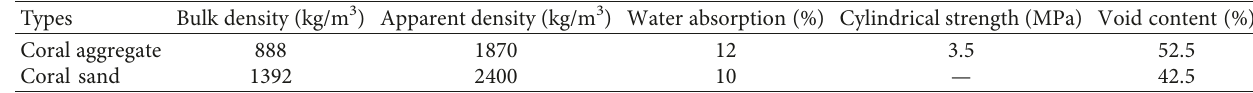
Figure 1: Coral aggregate from Southern China Sea island. (a) Coral aggregate. (b) Coral sand. (c) Size distribution of coral aggregates. (d) Water absorption δ w versus time. Table 1: Physical property of coral aggregate.